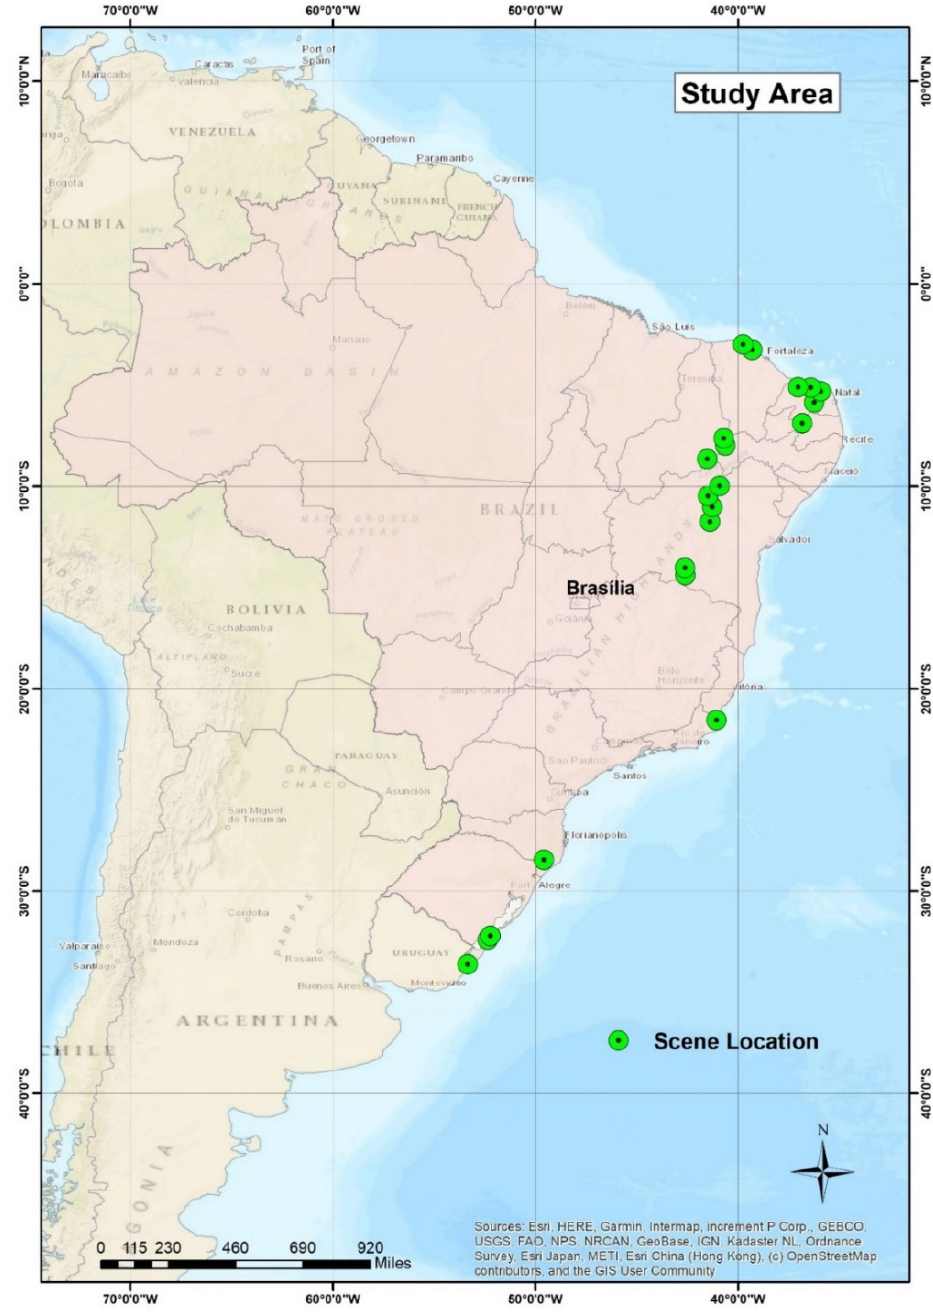
Figure 2. Location of all 21 CBERS 4A scenes used in this study.